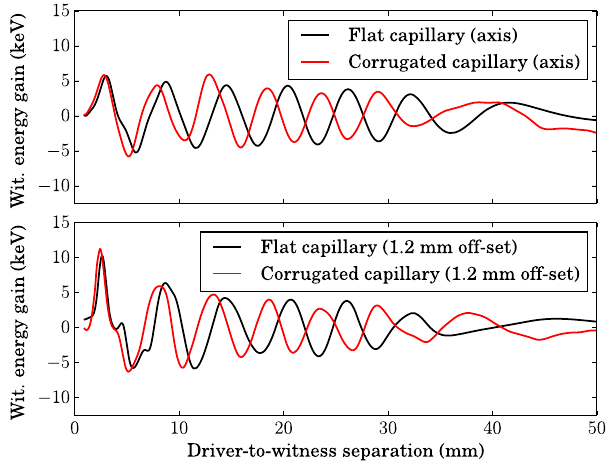
FIG. 4. Predicted on-axis and 1.2 mm off-axis acceleration- deceleration vs bunch separation.